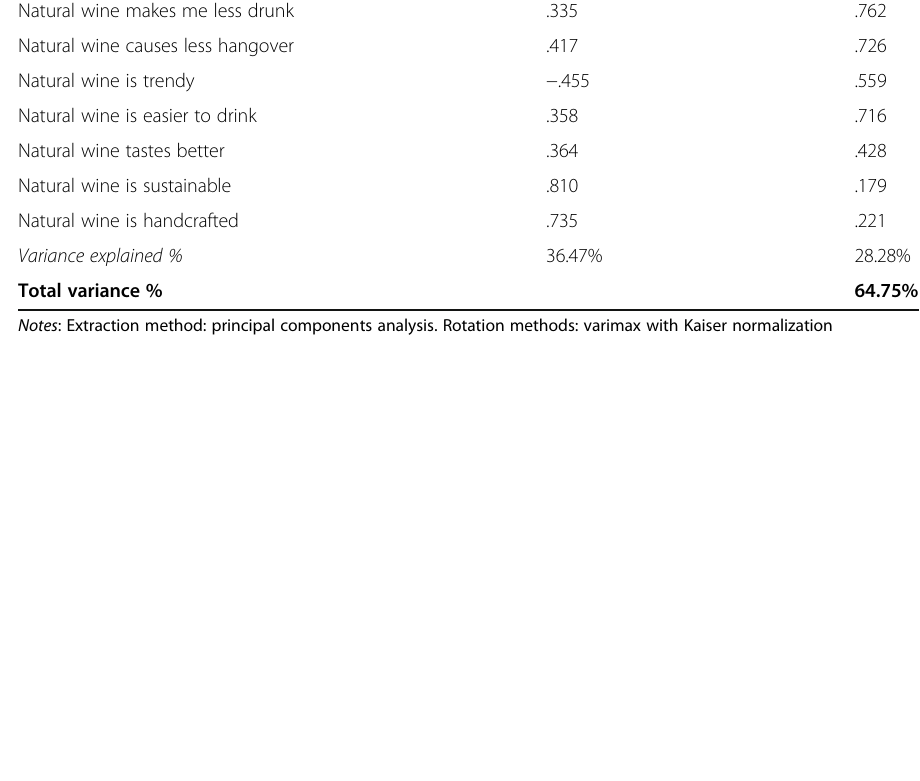
Table 8 Ordered logistic regressions coefficients and standard errors